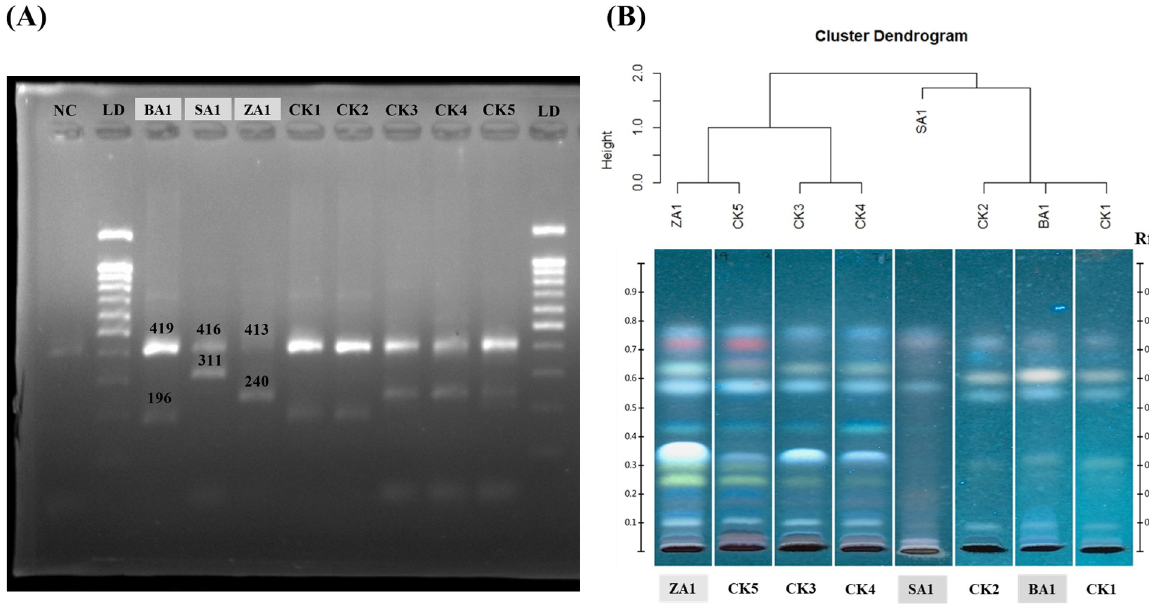
Fig 6. Commercial KSK crude drugs (CK1-CK5) were identified by comparison with BA1, SA1, and ZA1 in the gray blanket. (A) Image of the amplicons from multiplex PCR detected by 2.2% agarose gel electrophoreses. NC = negative control ( S . nux-blanda ); LD = ladder. (B) Cluster dendrogram by HCA analysis and TLC fingerprints under UV light at 366 nm after derivatization with anisaldehyde-sulfuric acid.